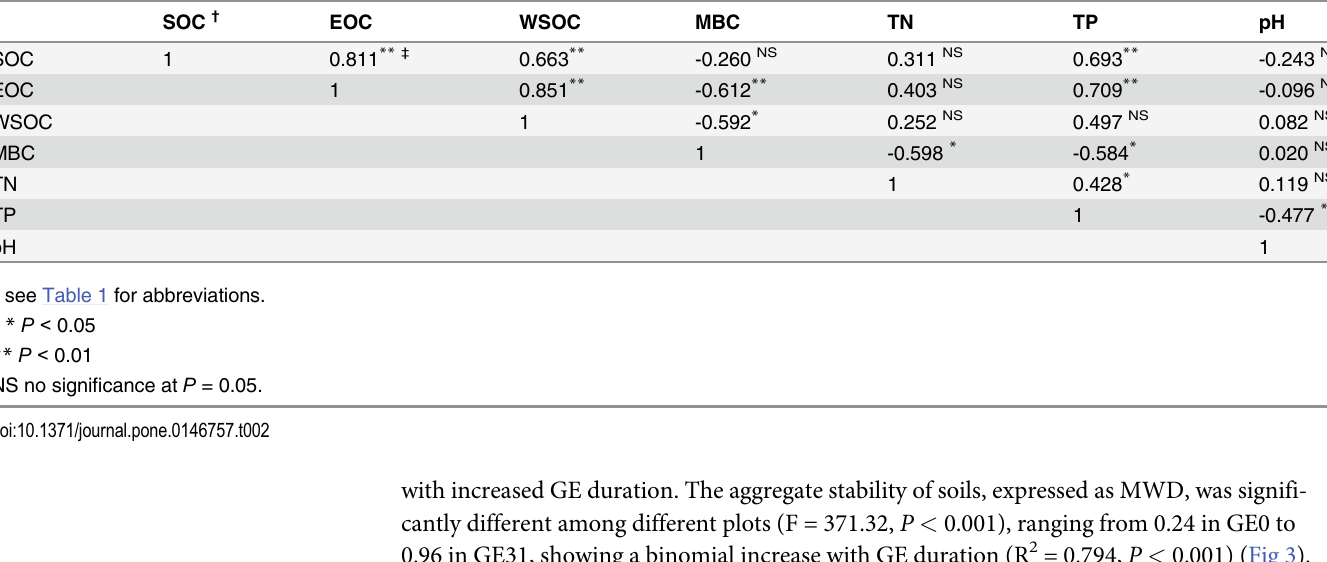
Table 2. Pearson correlation coefficients among organic carbon components and other soil properties.